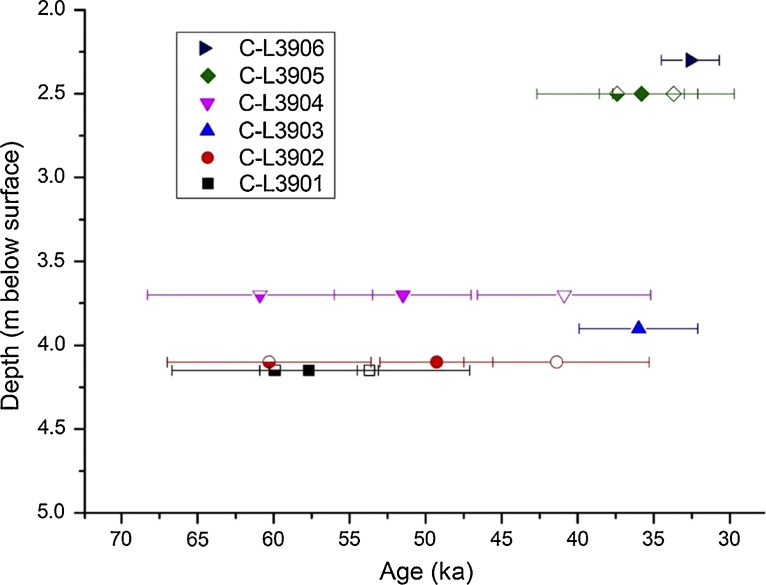
La Boja OSL dating. Age (±1σ) vs depth plot of luminescence dates. Filled symbols: quartz OSL results. Open symbols: feldspar IR50 results. Half-open symbols: feldspar pIRIR290 results.